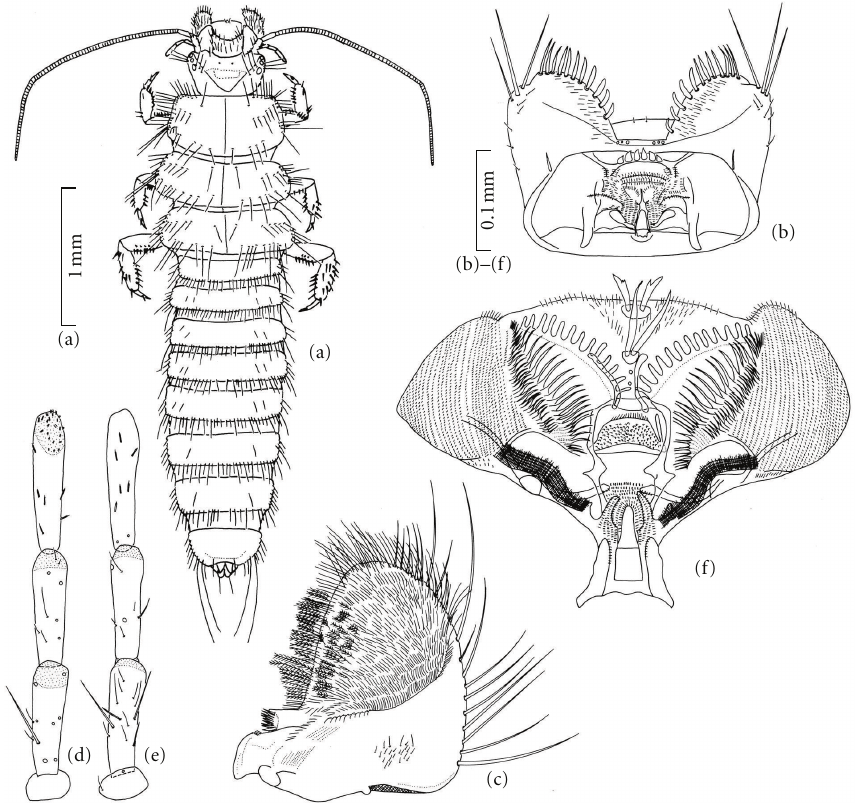
Figure 4: Hydrocyphon takizawai sp.n., larva. (a) Dorsal habitus; (b) labrum in ventral aspect; (c) mandible in ventral aspect; (d) maxillary palpus in ventral aspect; (e) ditto in dorsal aspect; (f)